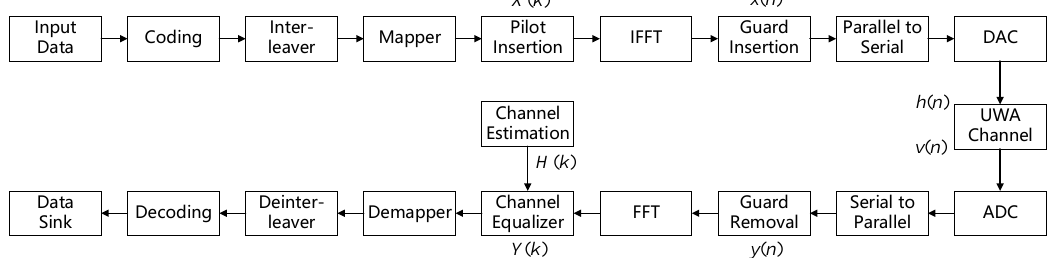
Figure 1. Block diagram of orthogonal frequency division multiplexing (OFDM) system